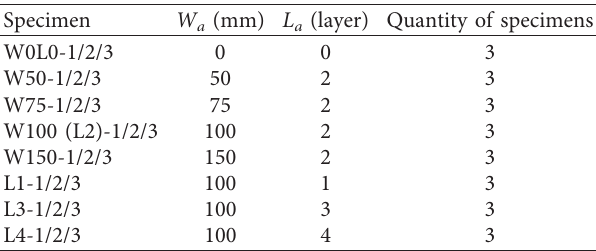
Figure 1: Detailed dimensions of the test specimen (unit: mm). Table 1: Specimen